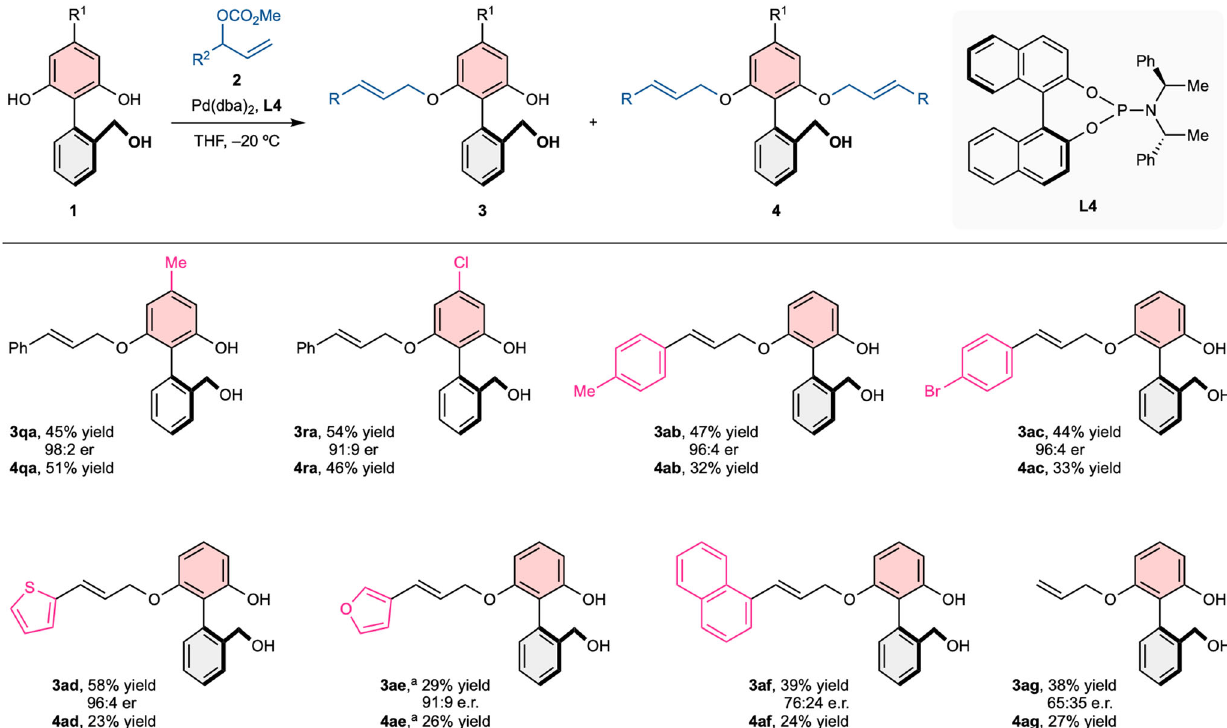
Fig. 3 Substrate scope of top aromatic ring and allyl carbonate. Unless otherwise noted, the reactions were carried out with 1 (0.10 mmol, 1.0 equiv), 2a ′ (0.15 mmol, 1.5 equiv), Pd(dba) 2 (0.001 mmol, 0.01 equiv), L4 (0.004 mmol, 0.04 equiv), THF (0.5 mL, 0.2 M). Isolated yields. Enantiomeric ratios were determined by chiral-phase high-performance liquid chromatography analysis. a 0.05 equiv of Pd(dba) 2 and 0.20 equiv of L4 were